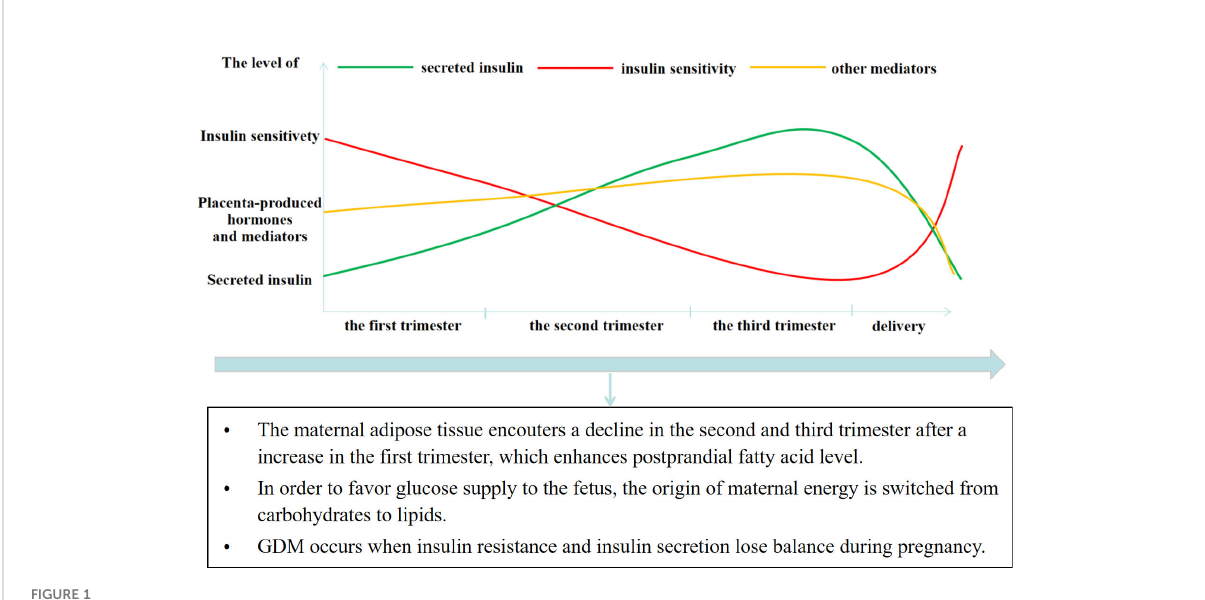
FIGURE 1 The glucose metabolism alteration and its in fl uences in